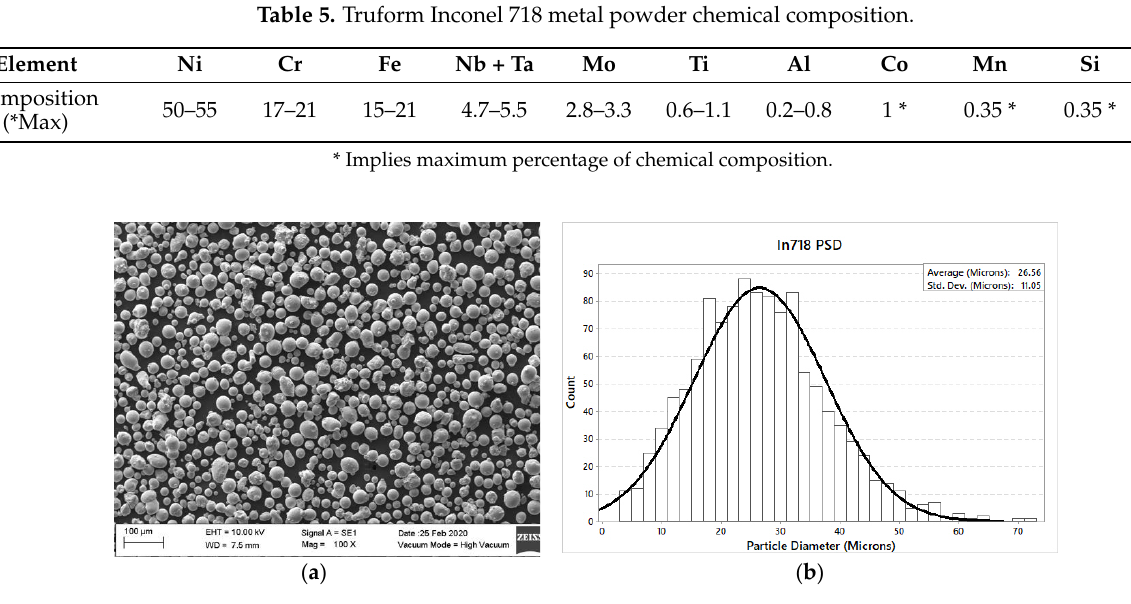
Figure 2. Experimental set-up for the selective laser melting of In718 cubes. The main elements of the experimental set-up are marked: (1) overflow, (2) build plate, (3) powder feed container, (4)